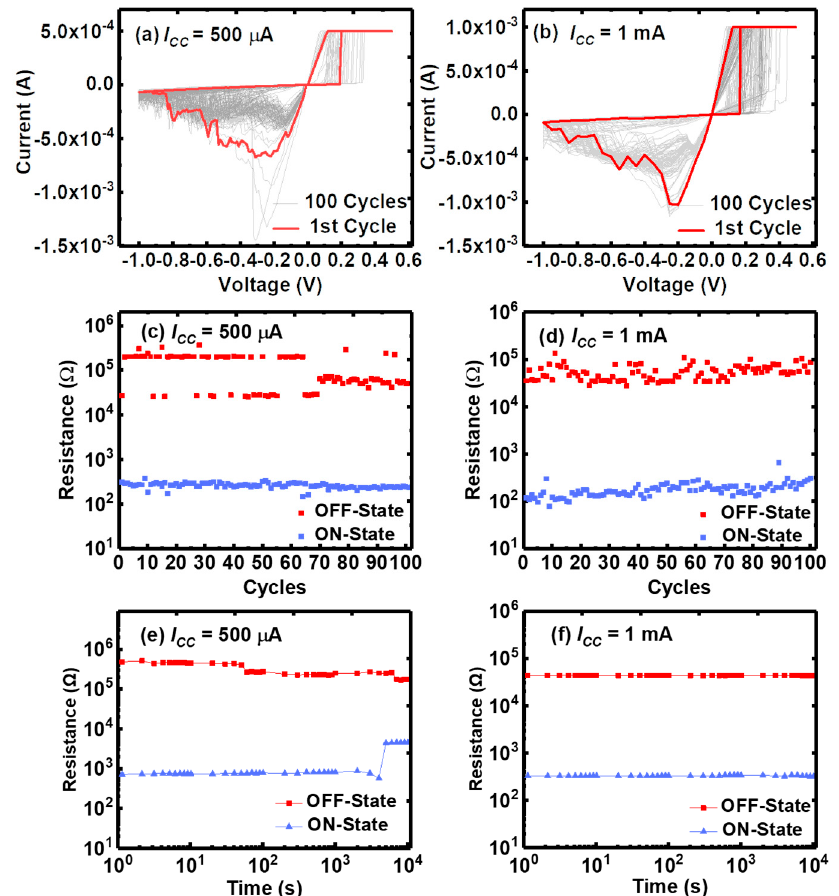
Figure 3. Typical resistance switching (RS) I-V curves of 100 consecutive cycles (gray curves) under the compliance current limits of ( a ) 500 µ A and ( b ) 1 mA, respectively. ON and OFF resistance states during 100 cycles under the compliance current limit of ( c ) 500 µ A and ( d ) 1 mA, respectively, extracted at 0.01 V. The data retention under the compliance current limits of ( e ) 500 µ A and ( f ) 1 mA for the same